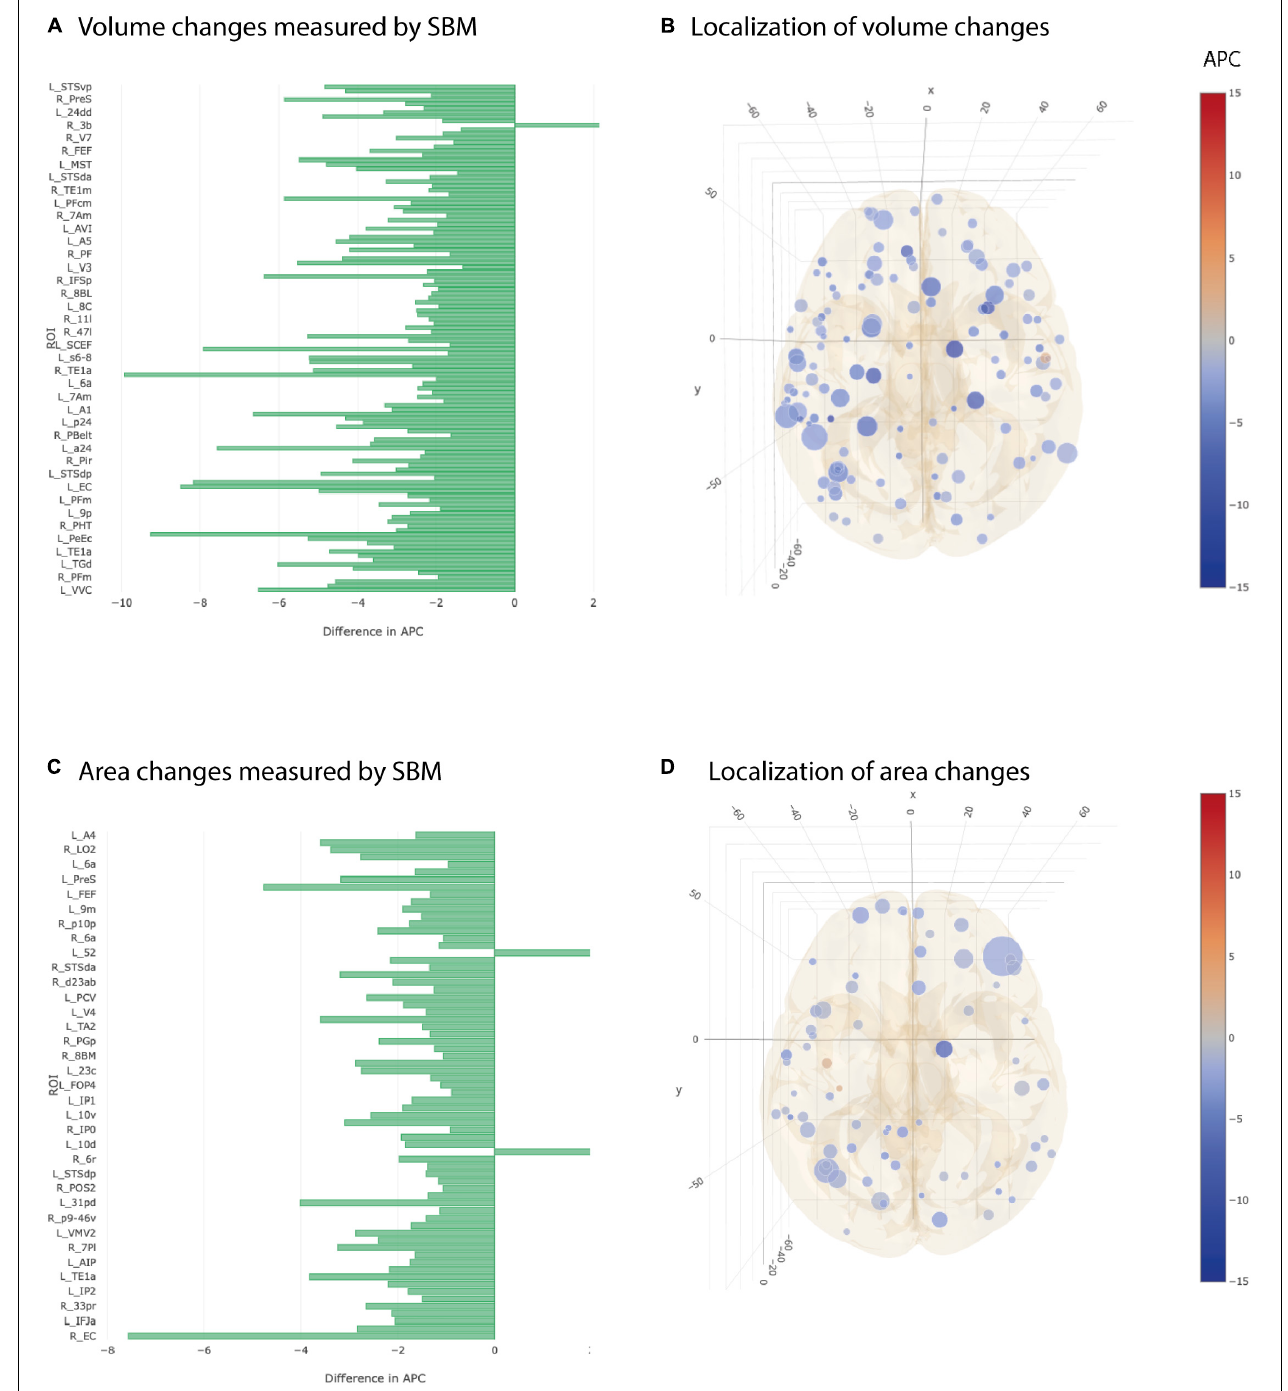
FIGURE 3 | Significant differences at individual testing level of annual percent changes in cortical volume and area (longitudinal SBM). (A) Horizontal bar plot of differences in group averaged cortical volume changes measured by SBM between AD and CN groups. Bars to the left indicate a relatively stronger decrease in APC values in AD group than in CN group. (B) 3D lattice graph of ROIs with significant differences in cortical volume changes shown in APC differences corresponding to panel (A) . Each circle is located at the center of mass of the corresponding ROI in MNI152 coordinate space. Color code indicates extend and sign of APC group differences whereas the diameter indicates absolute effect size. Brain hull was derived from a T1-weighted MR image in MNI152 standard space. (C) Horizontal bar plot of differences in group averaged cortical area changes measured by longitudinal SBM between AD and CN groups. Bars to the left indicate a relatively stronger decrease in APC values in AD group than in CN group. (D) 3D lattice graph of ROIs with significant differences in area changes shown in APC differences corresponding to panel (C) .